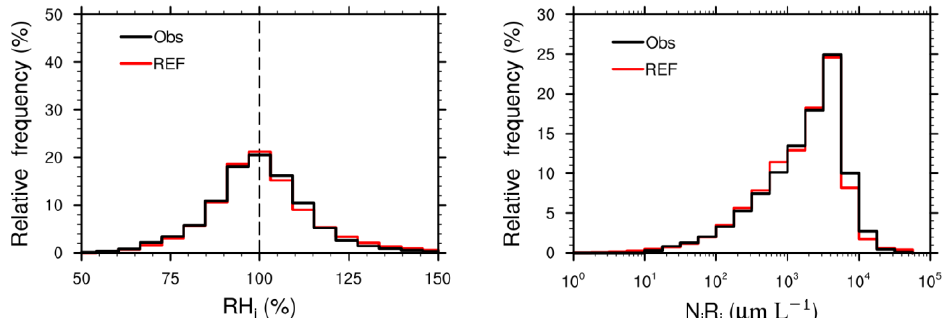
Figure 4. The occurrence frequencies of N i R i and RH i from observations (black lines) and the REF experiment (red lines). The dotted line indicates RH i = 100%.